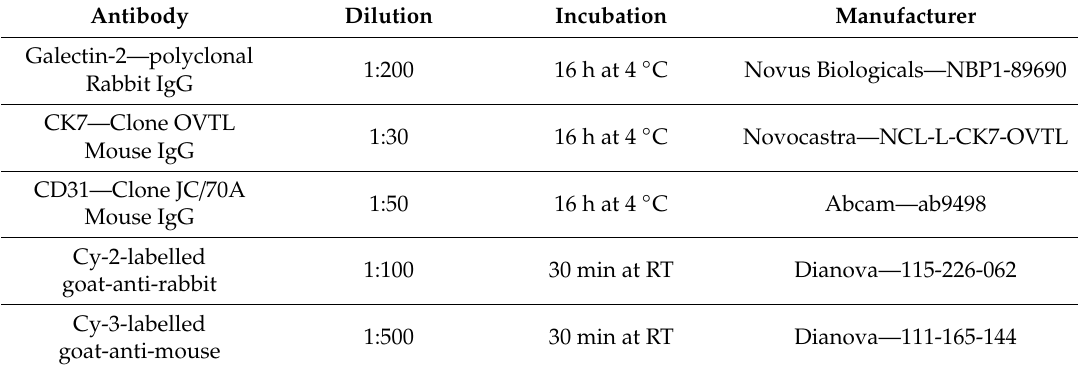
Table 4. Antibody features used for